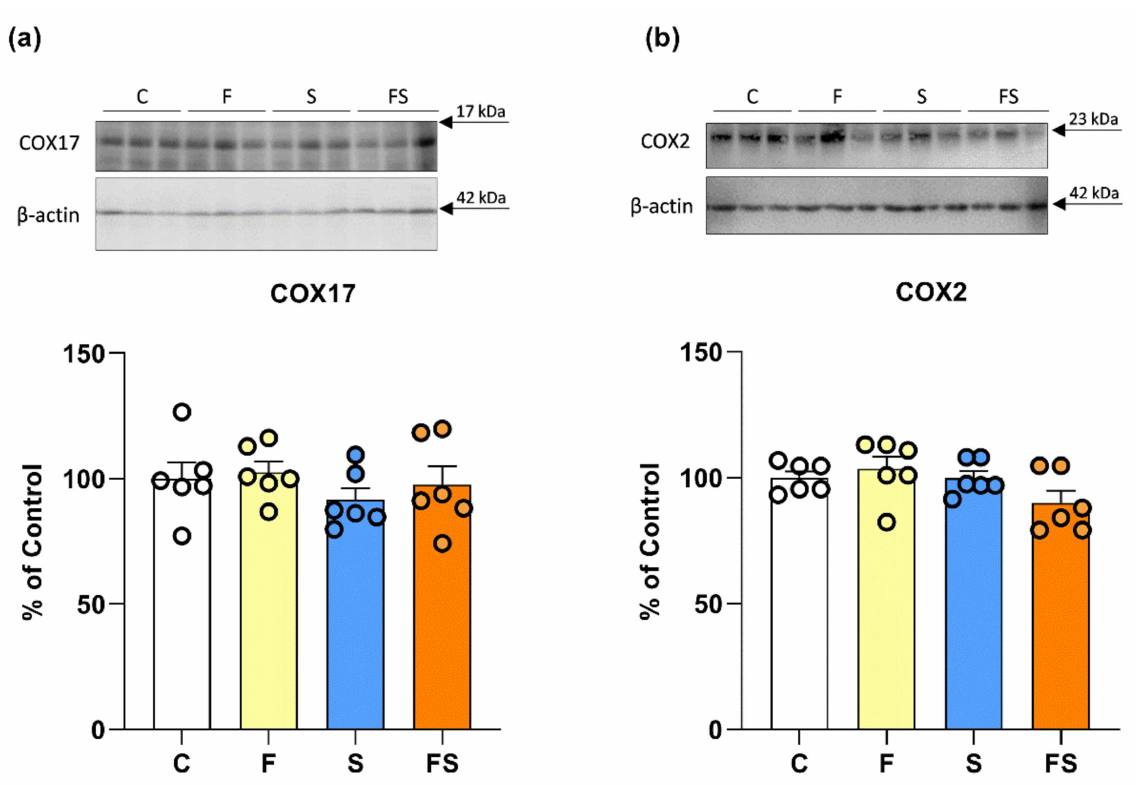
Figure 2. Effects of liquid fructose supplementation and/or stress on COX17 and COX2 protein level. Groups: control (C), fructose-fed (F), stress (S) and fructose + stress (FS). Protein level of COX17 ( a ) and COX2 ( b ) in renal whole cell extracts was measured by Western blot. Scatter plot with bar graphs represent the means ± SEMs for each protein normalized to β -actin and expressed relative to controls ( n = 6 animals/group). Two-way ANOVA was used to evaluate the effects of fructose and stress, and their